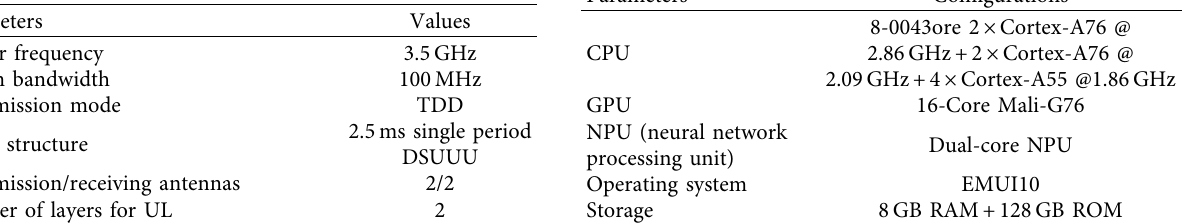
Figure 4: EIRA hardware testbed with a 5G NR protocol stack. Table 3: Confgurations for the commercial Table 1: Transmission confgurations of RAN.